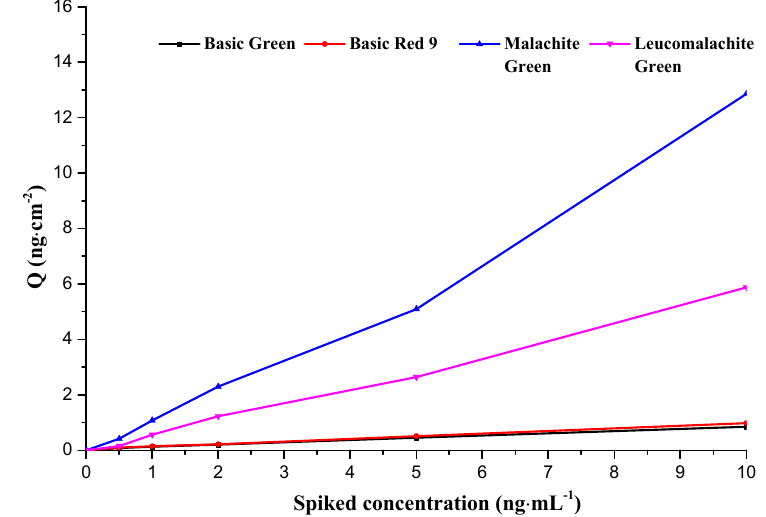
Figure 9. Adsorption curves of MG ‐ MIM for different substances.